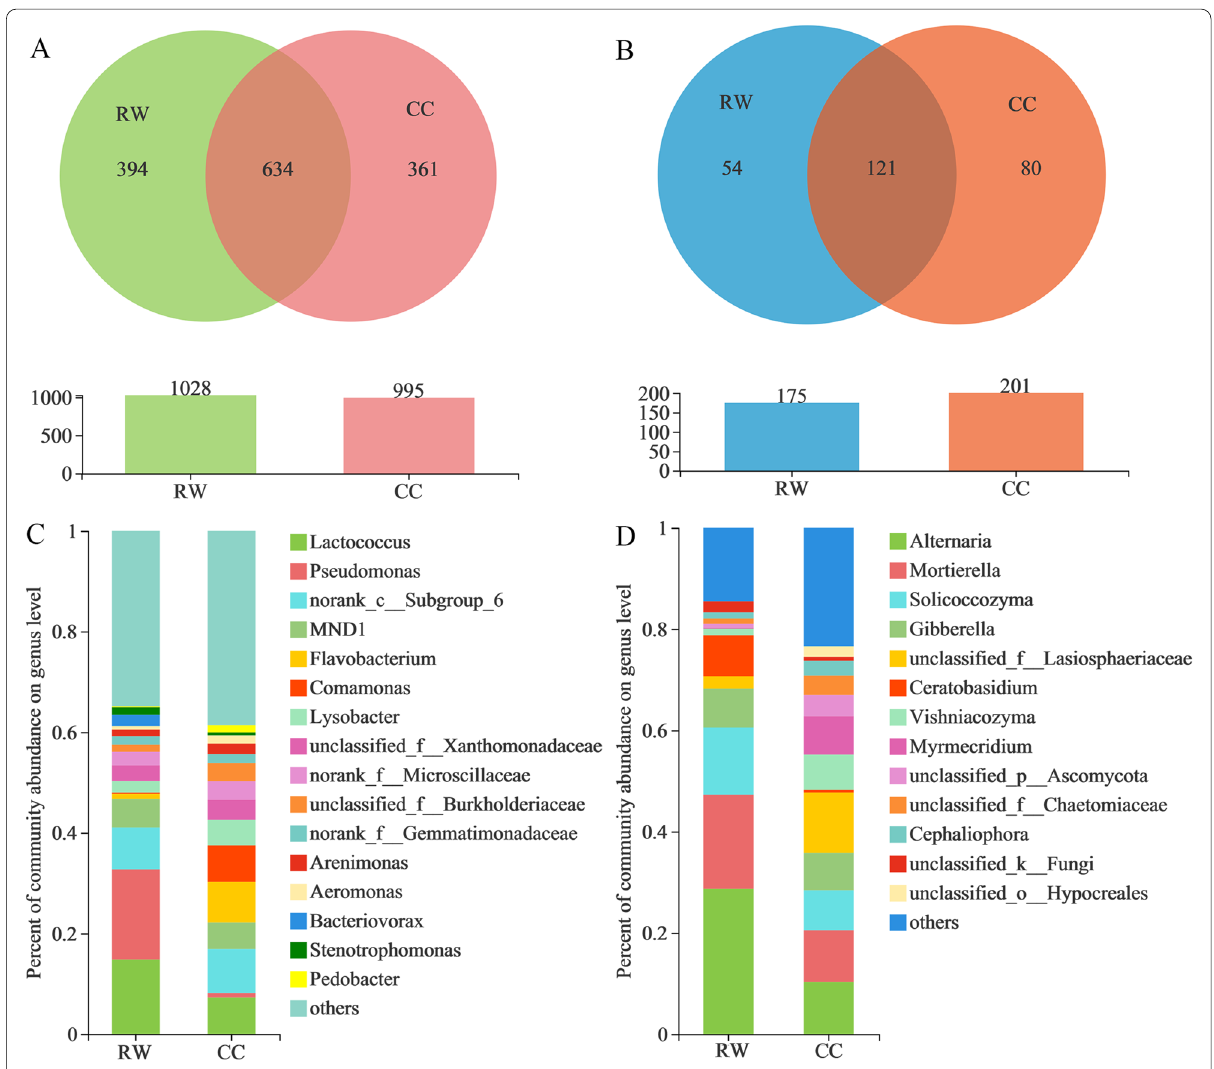
Fig. 3 Venn plots and relative abundance of bacteria and fungi in RW and CC, n plot of fungal OTUs between RW and CC, C relative abundance of bacteria community at genus level in RW and CC (others < 0.01), and D relative abundance of fungi community at genus level in RW and CC (others <